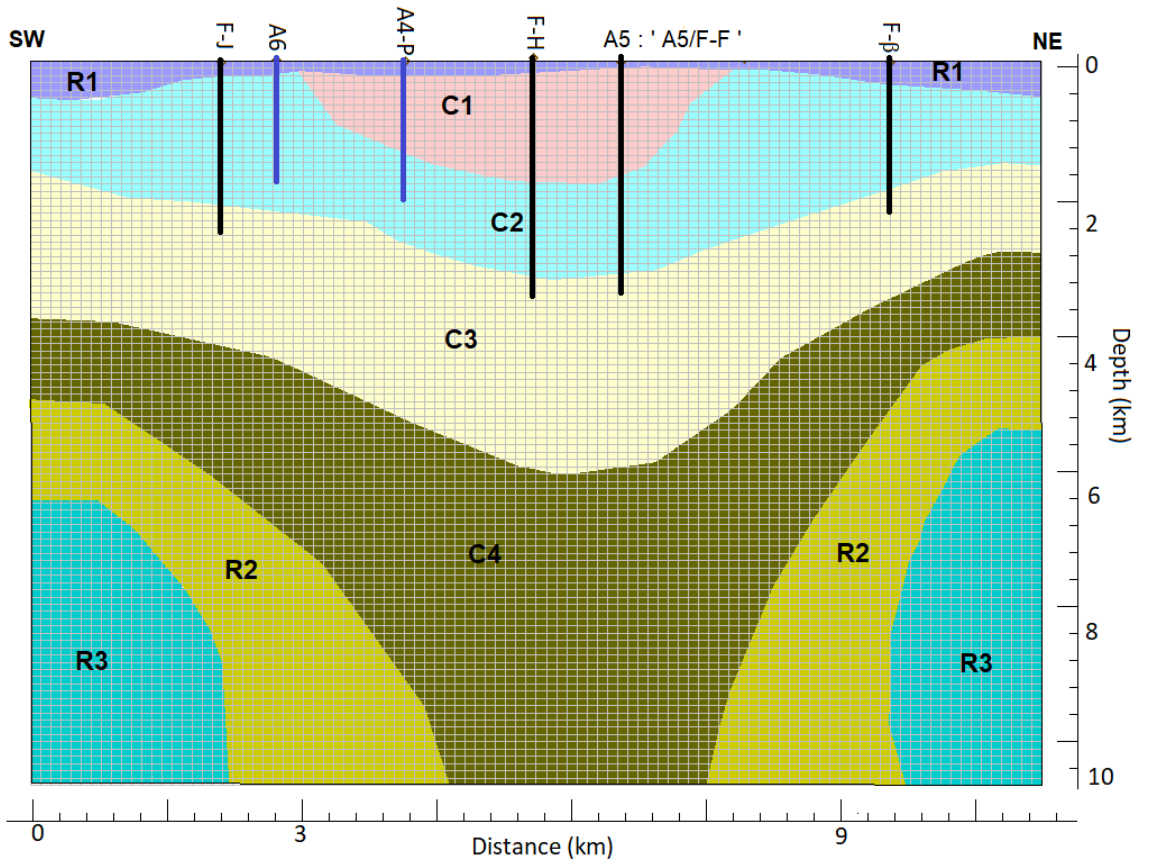
Figure 2. A 2D finite difference grid and conceptual model interpreted from a 2D magnetotelluric profile of the Asal rift (Figure 1). F-J, F-H, F- β indicate the emplacement of faults with their name; for example, F-J is the fault J location. A6, A-4P (projected A4 well), and A5 are the geothermal wells (Figure 1). A5 is located at the same position of F- F and is denoted A5: ‘A5/F - F’.